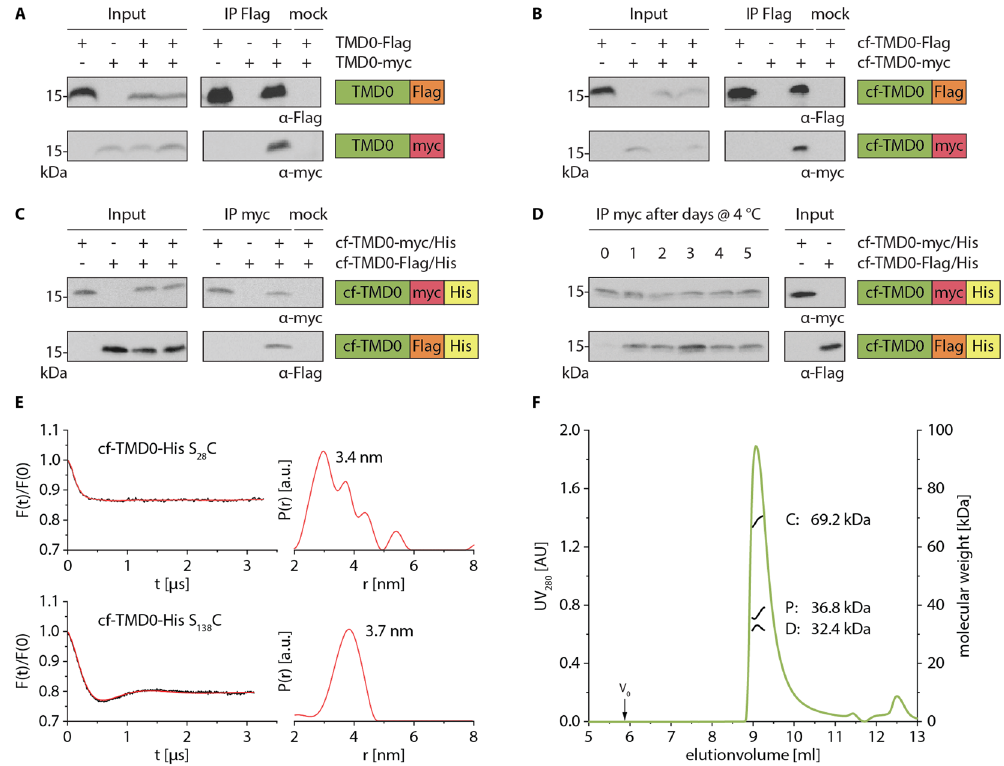
Figure 3. TMD0 oligomerization. ( A , B ) To test oligomerization of TMD0 in cellular environment, HEK 293 T cells were transiently transfected with wt (A) and cf variants ( B ) of TMD0 carrying a C-terminal Flag- or myc- tag. After solubilization with 1% digitonin, co-immunoprecipitation with Flag-tag specific antibody or isotype control (mock) was performed and analyzed by immunoblotting. Input represents 1/25 aliquot of the volume used for immunoprecipitation. Original, uncropped immunoblots are shown in supplementary information. ( C ) To analyze oligomerization of cf expressed TMD0, precipitates of separately produced cf-TMD0-myc/ His and cf-TMD0-Flag/His were mixed, solubilized in LMPG, purified and reconstituted in c6-DHPC. Single or co-purified TMD0 variants (input) were immunoprecipitated by myc-tag specific antibody or isotype control and analyzed by immunoblotting. Input represents 1/15 aliquot of the volume used for pull-down. Original, uncropped immunoblots are shown in supplementary information. ( D ) To probe the oligomerization dynamics, cf expressed TMD0 variants were separately purified and refolded (input). Cf-TMD0-myc/His and cf-TMD0-Flag/His were mixed in a 1:1 molar ratio and incubated at 4 °C up to five days. Exchange of subunits was analyzed by immunoprecipitation with myc-tag specific antibody. Input represents 1/15 aliquot of the volume used for pull-down. Original, uncropped immunoblots are shown in supplementary information. ( E ) Oligomerization of MTSL labeled cf-TMD0-His S 28 C and cf-TMD0-His S 138 C was investigated by PELDOR spectroscopy. PELDOR traces were background corrected (left), and corresponding distance distributions were calculated by Tikhonov regularization (right). ( F ) Dimer formation of cf-TMD0-His was determined by SEC- MALS. 400 µ g of purified cf-TMD0-His were applied on a 15 ml TSK-Gel G3000 SWXL column (green line). Molecular weight distributions were calculated by three-detector method using Astra software and are depicted in black lines (C: protein-detergent conjugate, P: protein, D: